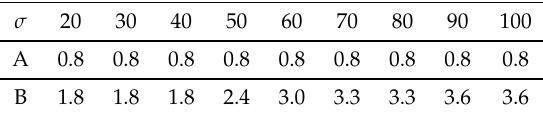
Table 1. The valuesof A and B